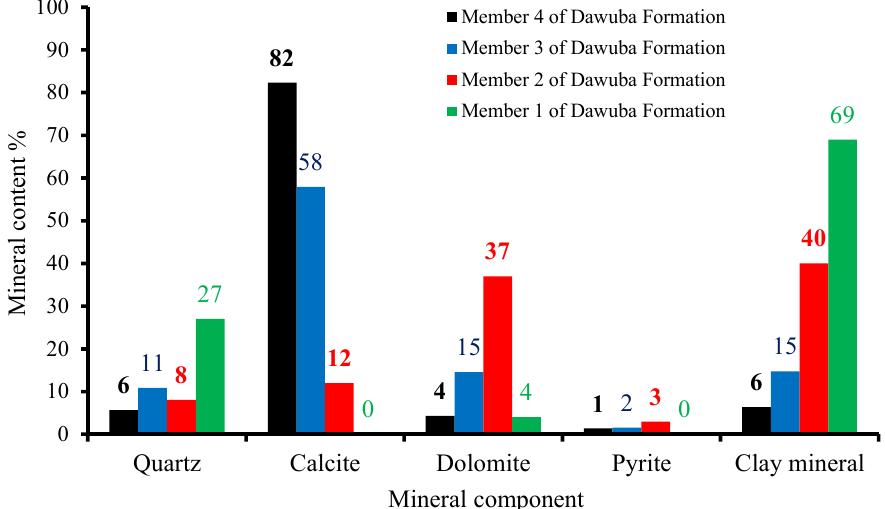
Figure 3. Mineral component content of the Dawuba Formation in Well QSD-1.